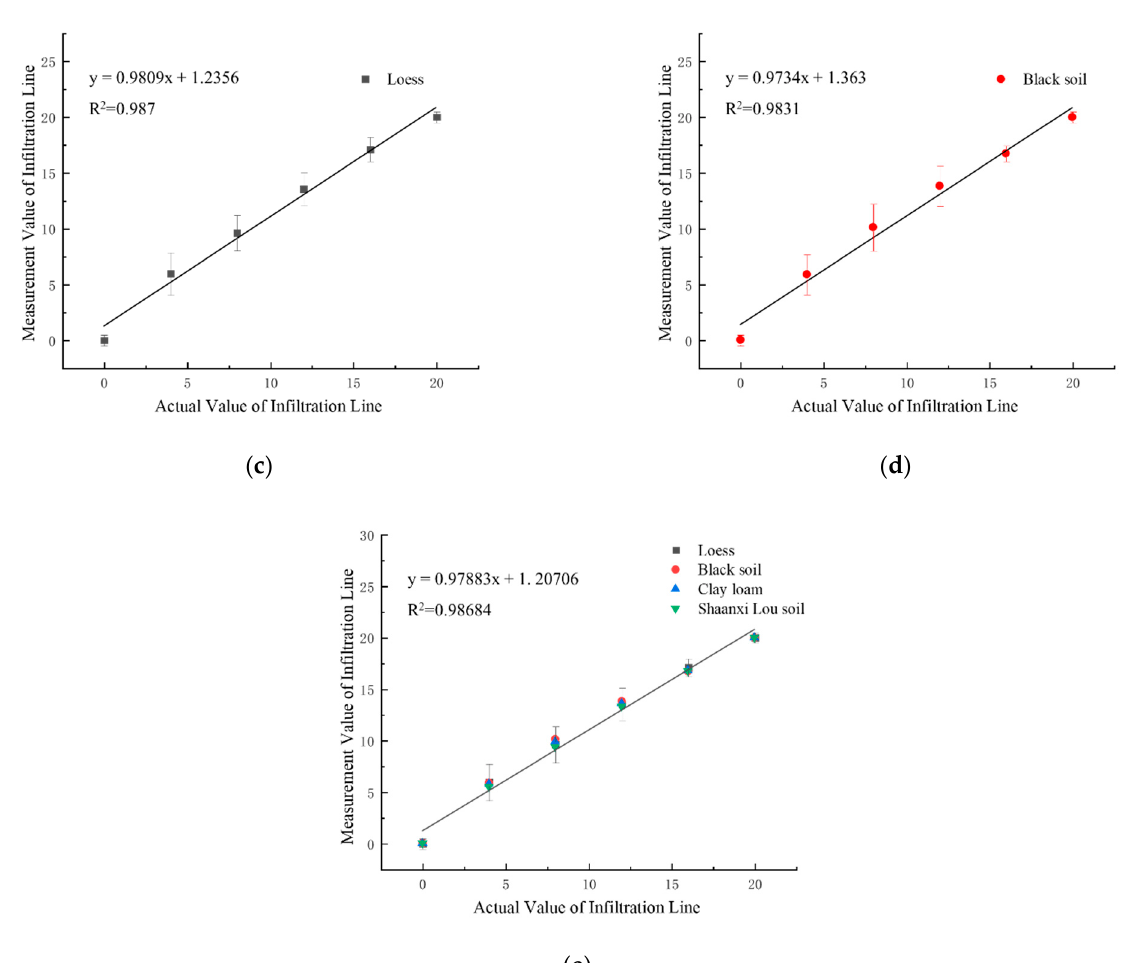
Figure 5. Correlation verification of two-layer soil infiltration line: ( a ) Shaanxi Lou soil; ( b ) clay loam; ( c ) loess; ( d ) black soil; ( e ) concatenated fitting of four soils.